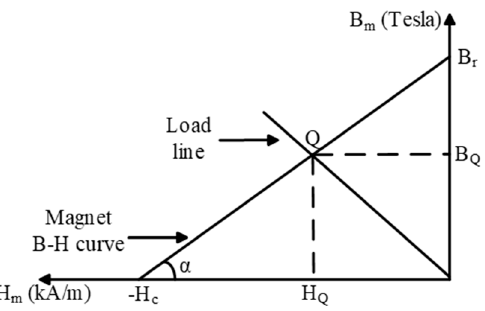
Figure 6. B–H curve and operating point of permanent magnet.